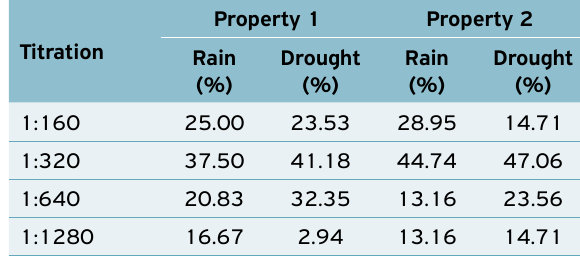
Table 4. Frequency distribution of indirect immunofluorescent assay (IFA) test reactive samples, accordingly with property, season of the year and titration, in an Anaplasma phagocytophilum serosurvey, at two regions of Minas Gerais, Brazil. Titration